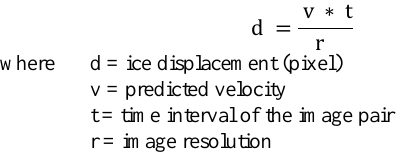
Table 1. Estimated Error for each type of image